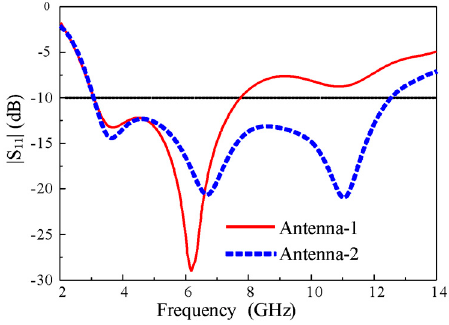
Figure 4. | S 11 | characteristics of Antenna-1 and Antenna-2. Figure 4. |S 11 | characteristics of Antenna-1 and Antenna-2. Figure 4. |S 11 | characteristics of Antenna-1 and Antenna-2.